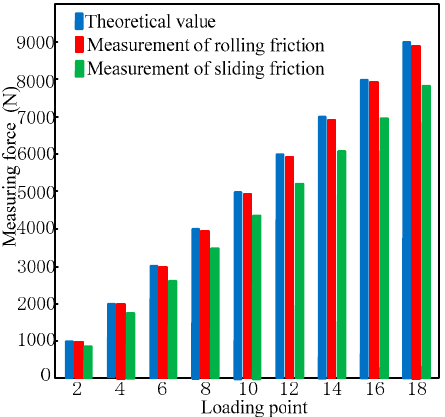
Figure 8. Comparison of calculated sensor loads accounting for various frictional forces.